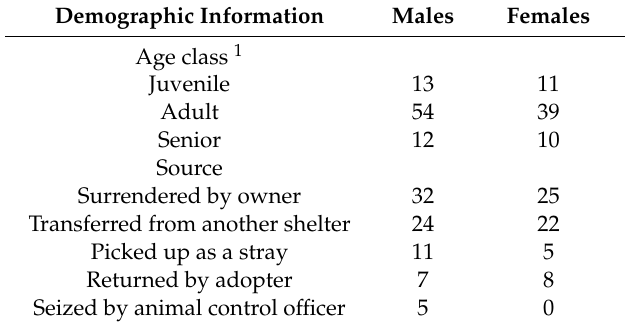
Table 2. Demographic data for dogs ( n = 139) whose adopters responded to our survey. Demographic